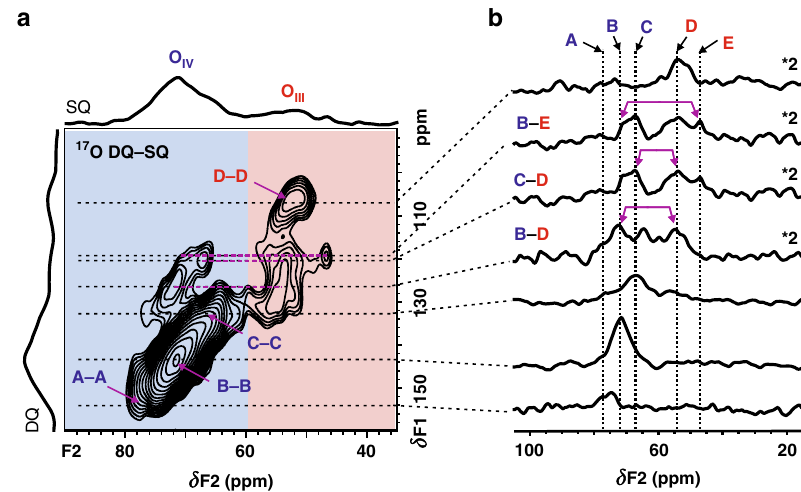
Fig. 2 Probing oxygen-oxygen proximities via 2D 17 O double quantum (DQ)- single quantum (SQ) experiments. a 2D 17 O MAS DQ-SQ homonuclear correlation NMR spectrum of γ -Al 2 O 3 recorded at 35.2 T and b extracted slices along F2 dimension. The acquisition time for the 2D spectrum is ca. 3.7 h. O IV and O III denote 4-coordinated and 3-coordinated oxygen sites, respectively. A-E denote fi ve individual oxygen sites, A-A, B-B, C-C and D-D represent the auto-correlations from the same oxygen sites, B-E, C-D and B-D represent the cross-correlations from two distinct oxygen sites. The purple arrows in b indicate the position of two coupled oxygen sites in the extracted